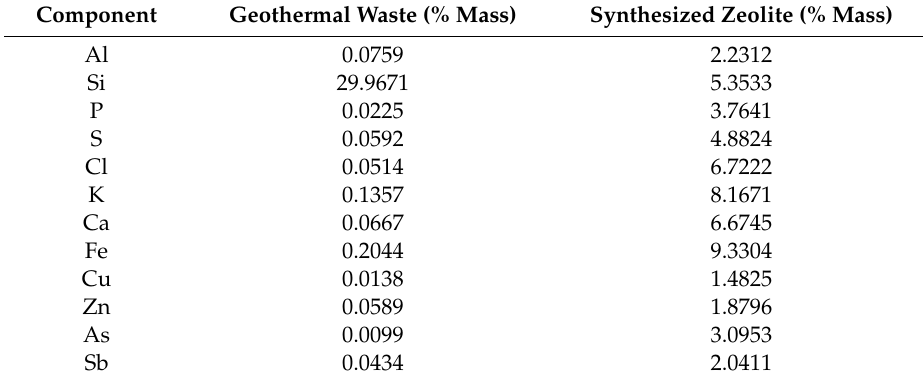
Table 3. Results of X-Ray Fluorescence (XRF) analysis of the geothermal waste and synthesized zeolite.